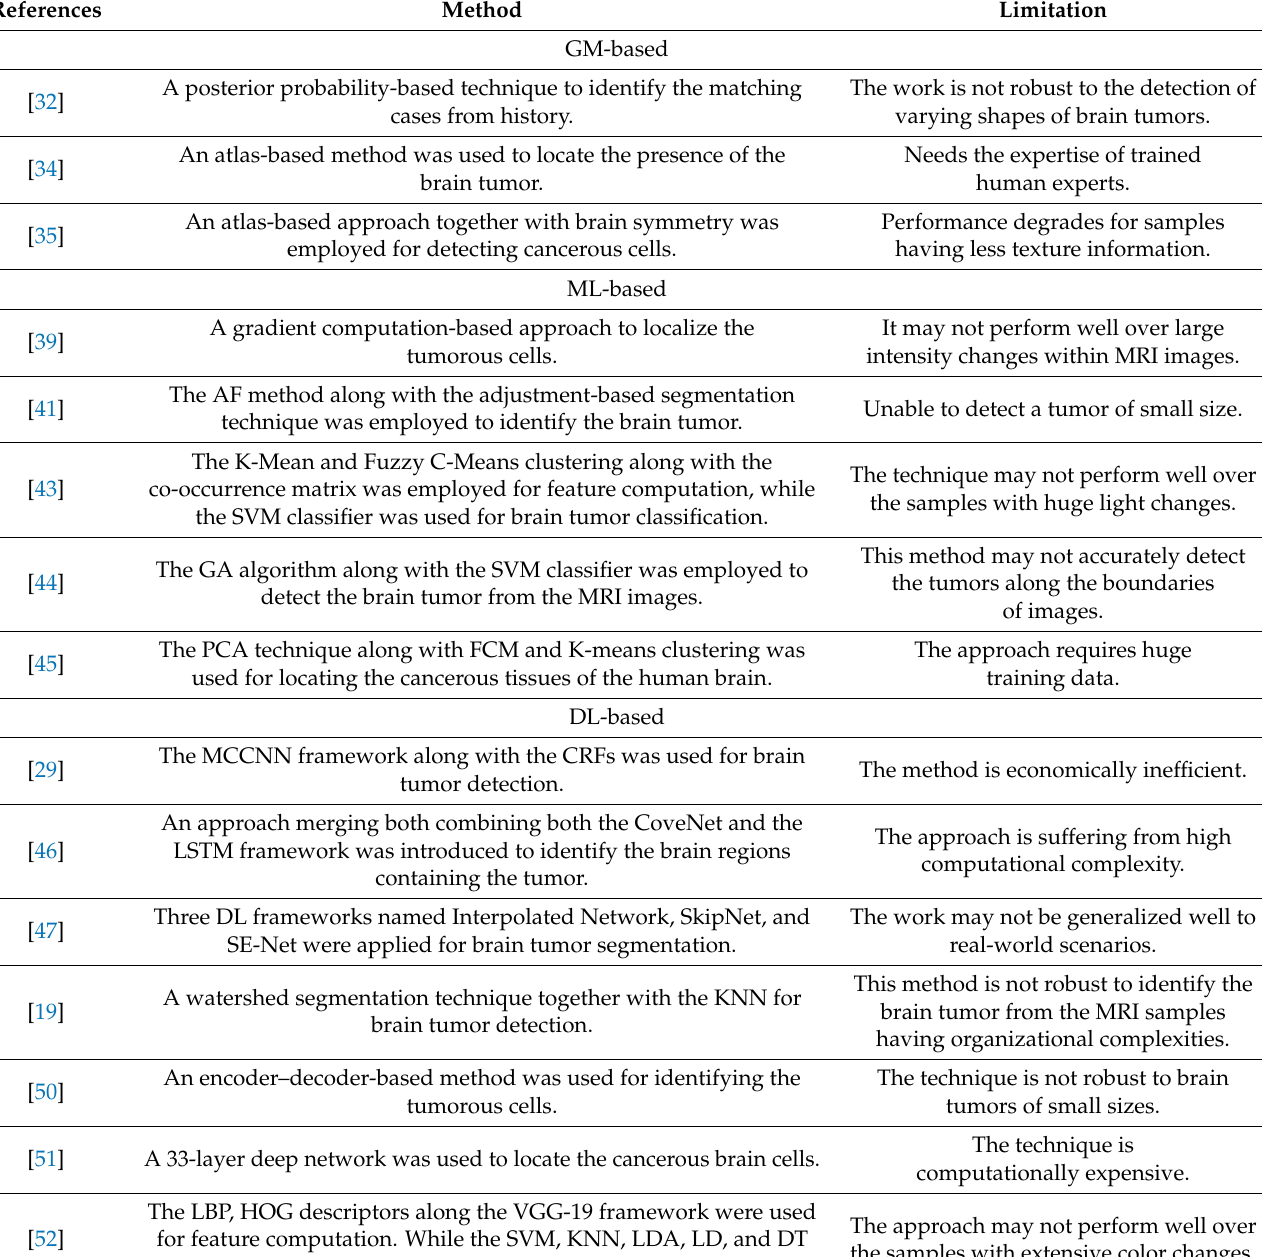
Table 1. Review of previous